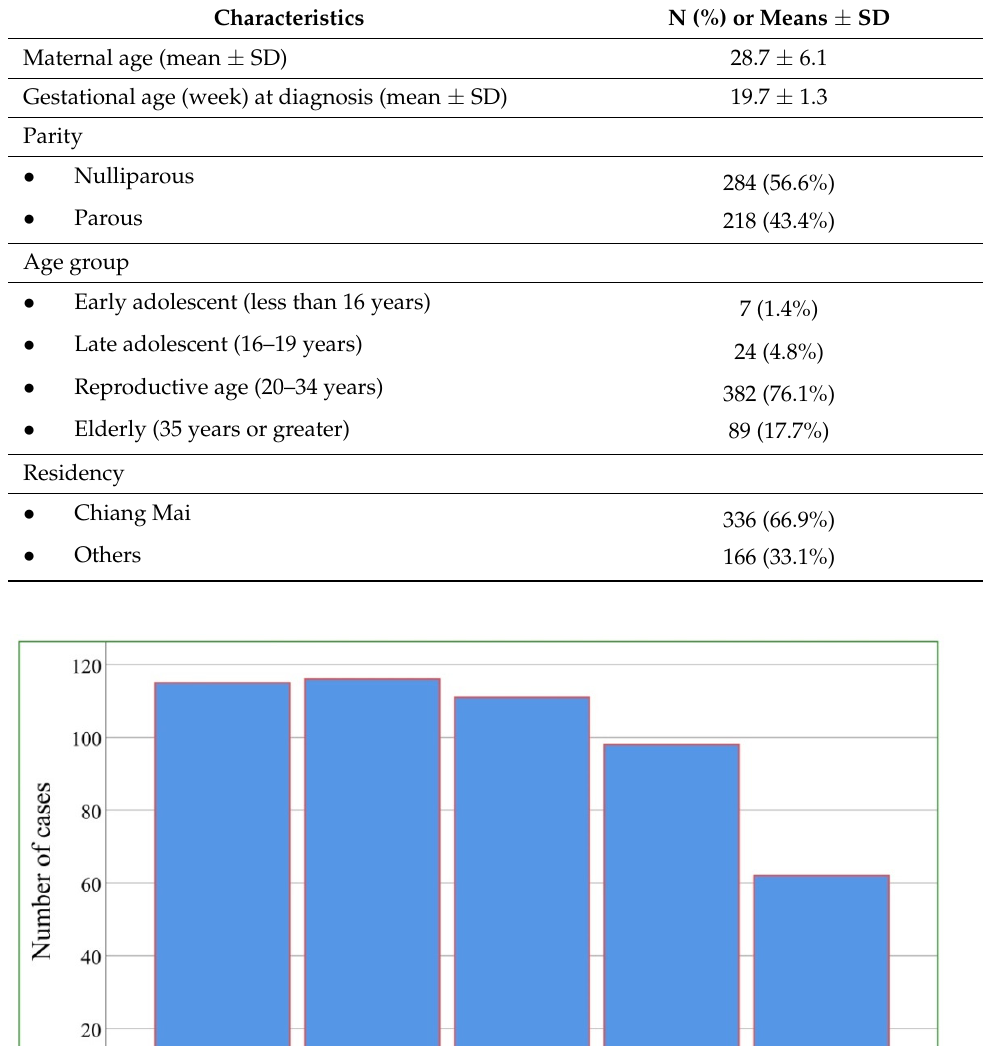
Table 1. Demographic data of the pregnant women.